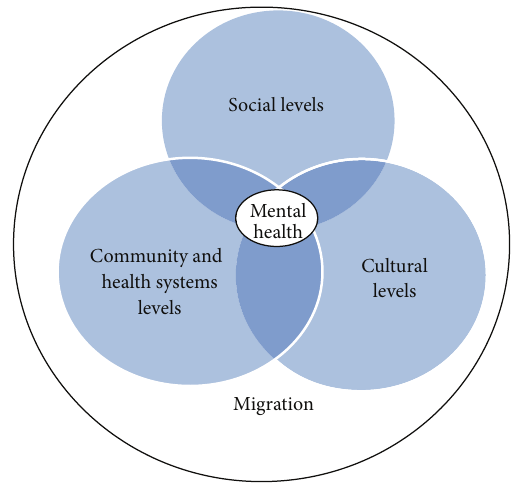
Figure 1: Female immigrants’ social determinants of mental